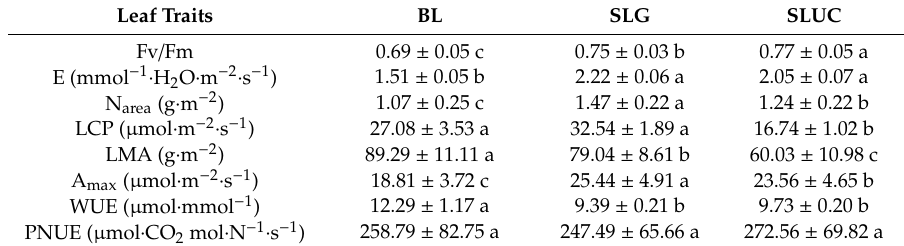
Table 3. Leaf traits of M. condensatus (Mean value ± SE; n = 48) in bare land (BL), shrub land gap (SLG) and shrub land under canopy (SLUC). Abbreviations are maximum quantum yield of PSII (Fv / Fm); transpiration rate (E); leaf N content (N area ); light compensation point (LCP); leaf mass per area (LMA); light-saturated photosynthetic rate (A max ); water use e ffi ciency (WUE); photosynthetic N use e ffi ciency (PNUE). For E, N area , LMA, A max , and PNUE, di ff erent letters indicate significant di ff erences between the study sites revealed by Tukey’s post hoc test at a significance level p < 0.05 after one-way ANOVA.